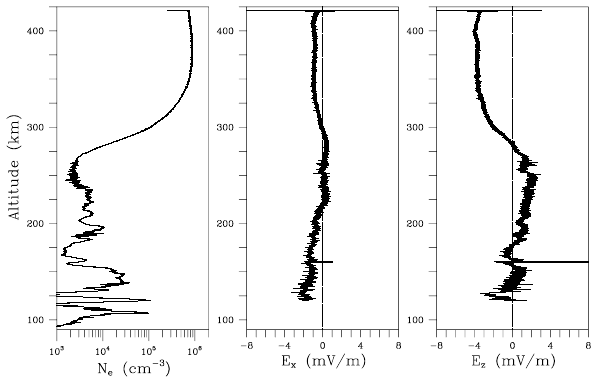
Fig. 7. Downleg data from the 7 August rocket flight. Left panel: electron density. Center panel: zonal electric field. Right panel: vertical electric